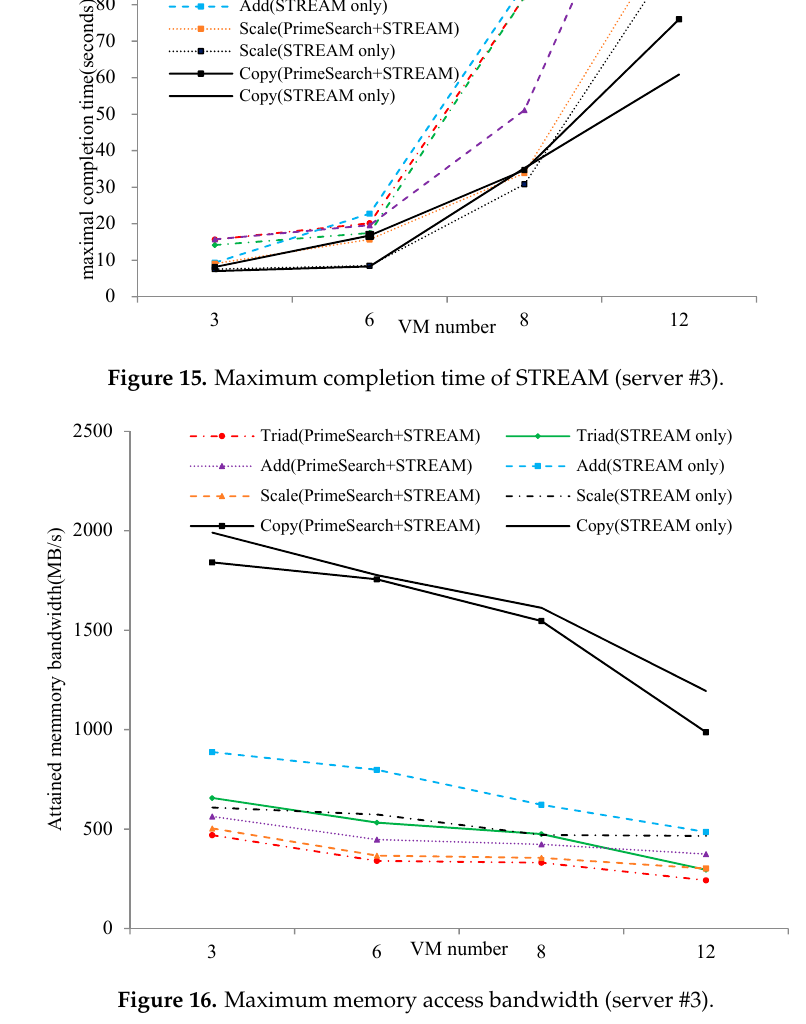
Table 8. Power consumption and performance comparison of different scheduling algorithms.